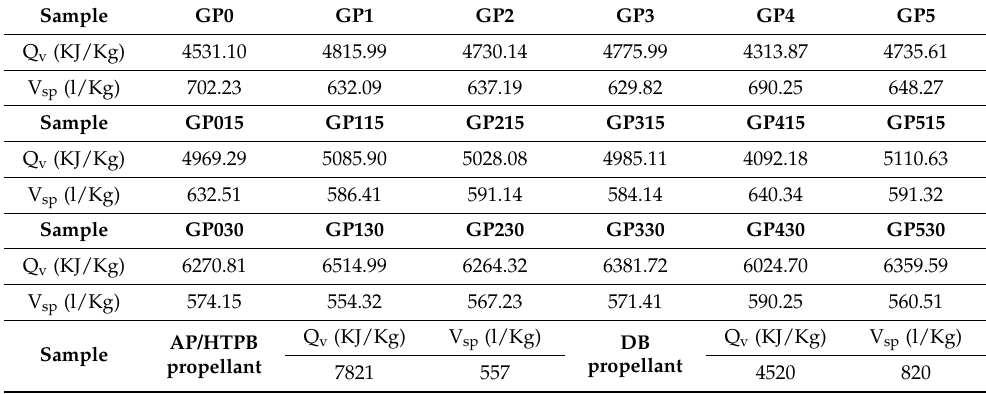
Table 8. Caloric and volume results of the “green” rocket propellant formulations.